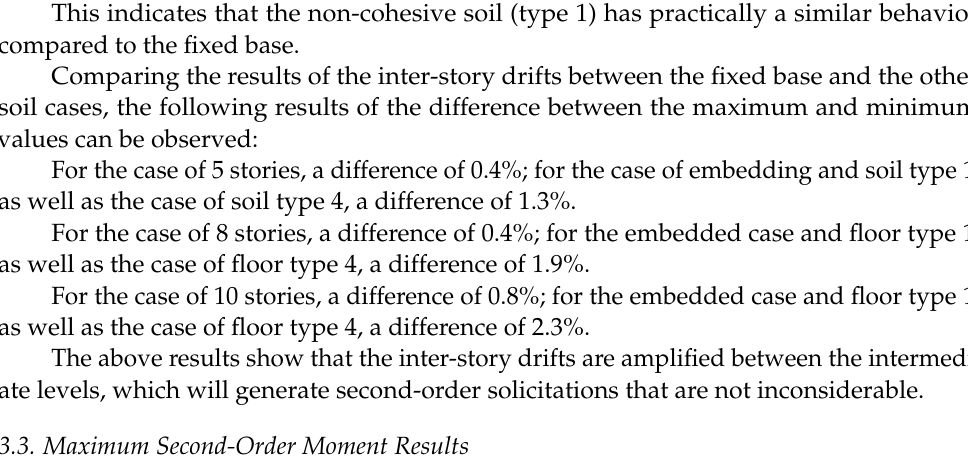
Figure 10. Inter-story drift case of a 10-story building .